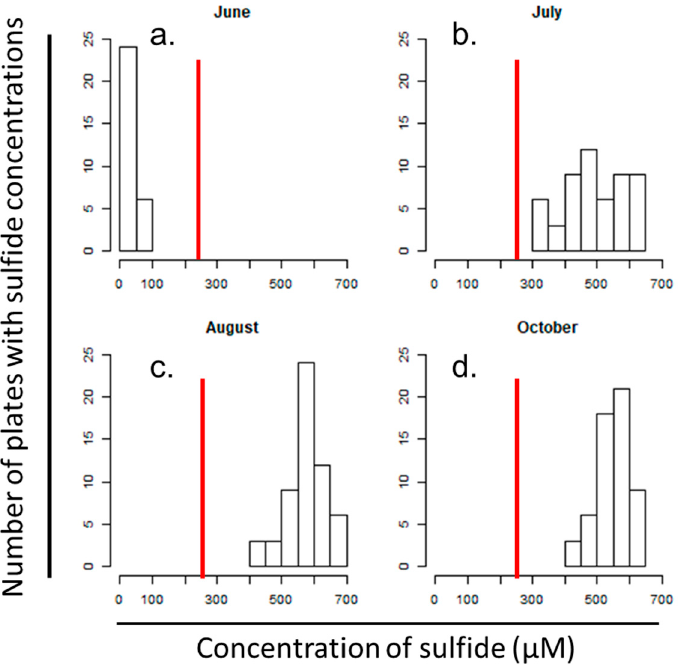
Figure 7. IRIS plate derived sulfide concentrations across site for each month throughout the incursion season. The frequency of each plate-averaged concentration is displayed on the y axis and the average concentration per plate is binned on the x axis in ( a ) June, ( b ) July, ( c ) August, and ( d ) October. Red vertical lines denote the detection limit of derived sulfide. Values below this limit indicate that FeS complexes were present, but concentration values are not reliable. Sulfide concentrations represent the average of each white, grey, and black pixel on the